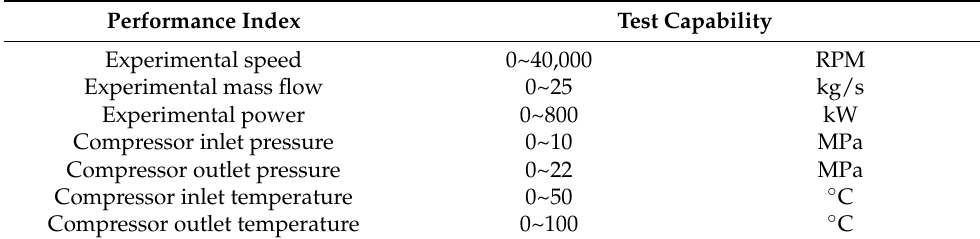
Table 4. Main performance of experimental platform for MWe sCO 2 compressor.